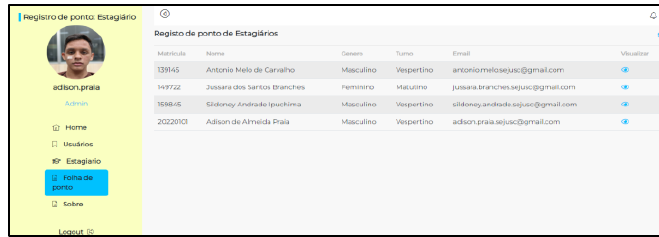
Figure 23: Trainee's list for time clocking consult.